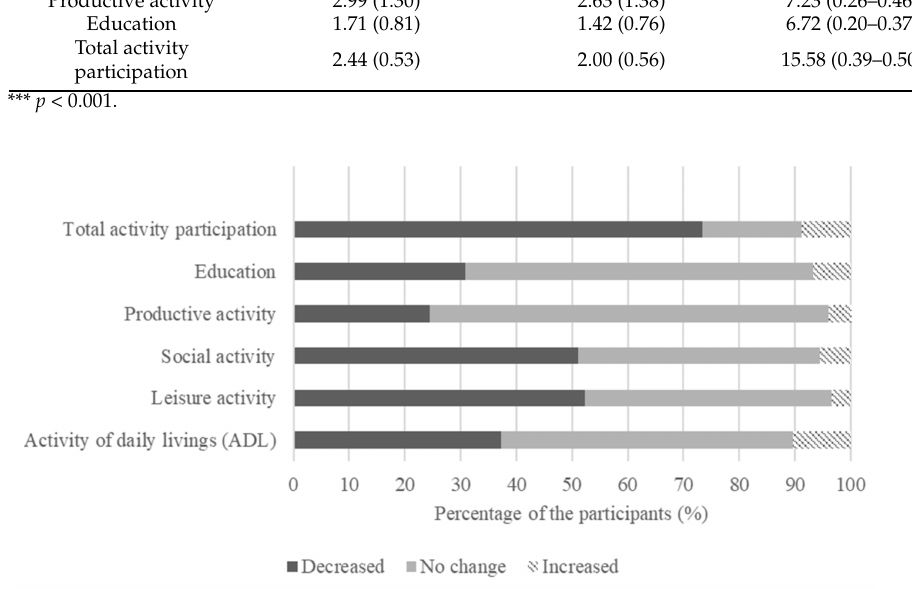
Figure 2. Percentage of population that reported differences in activity participation pre and post the outbreak of